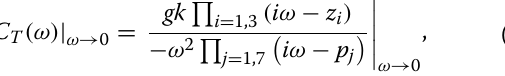
Table 3 The parameters and corresponding ranges used in grid search analysis Longitude (°)